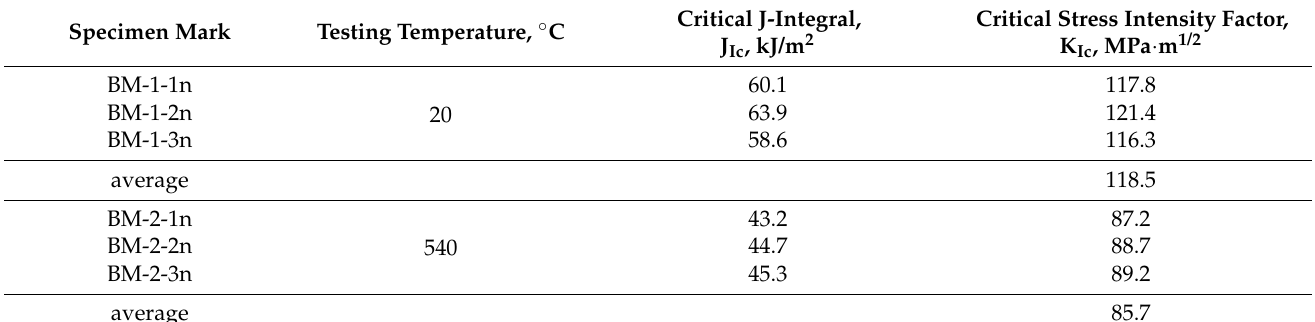
Table 13. Values of K Ic via J Ic for A387 Gr.